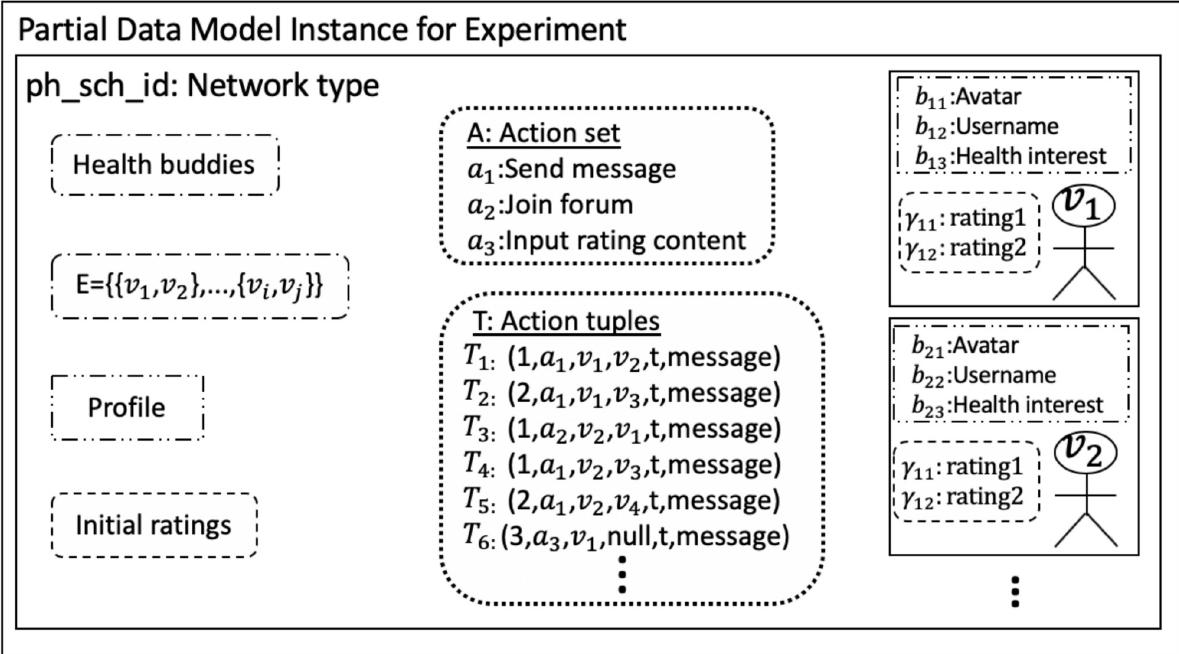
Fig 32. Elements of the data model (Table 3), for the online social network experiment in [3].